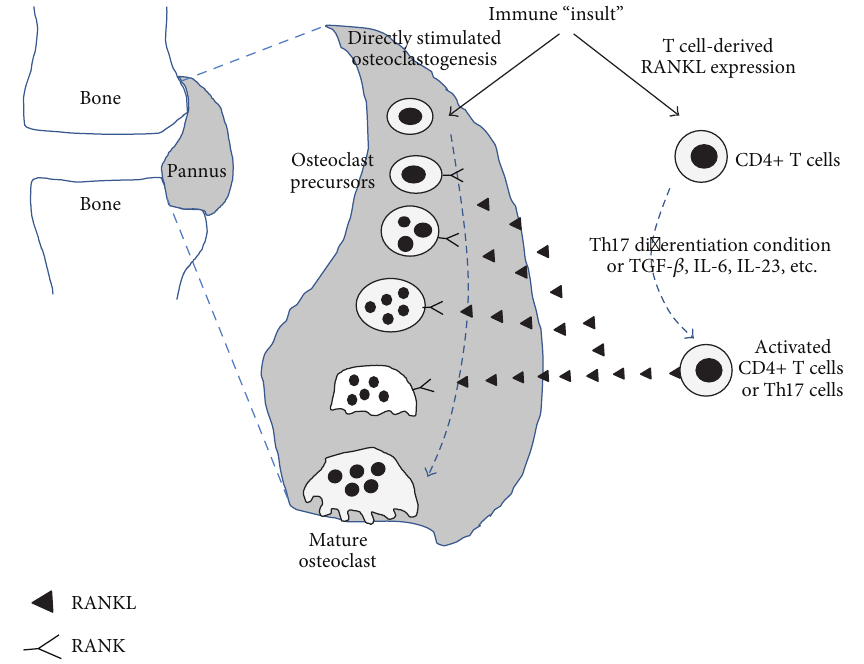
Figure 5: T cells are activated to produce RANKL or osteoclastogenic cytokines by various stimuli. RANKL and activated T cell-cytokines have the potential to induce osteoclastogenesis. With T cells, the outnumbered osteoclasts destroy the bone in